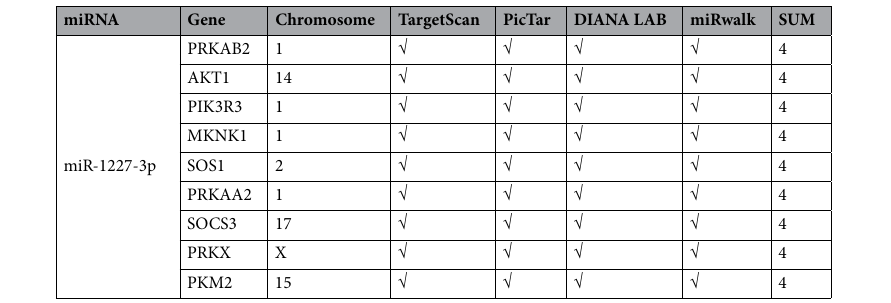
Table 3. Predicted target genes of